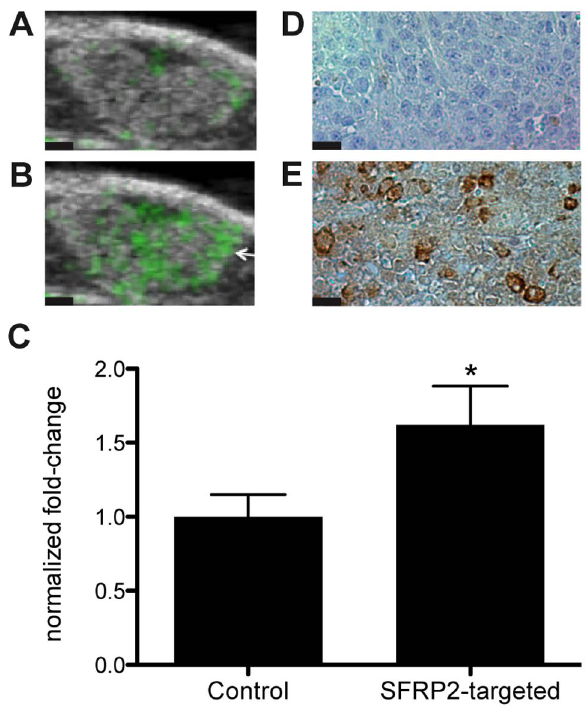
Figure 2. SFRP2 -targeted microbubbles bound specifically to vasculature within angiosarcoma. B-mode images of the SVR angiosarcoma tumors were overlaid in green with molecular images of (A) control streptavidin loaded microbubbles or (B) SFRP2 -targeted microbubbles after three-dimensional molecular imaging. The average pixel intensity observed for SFRP2 -targeted imaging was significantly higher (*p=0.003, n=13, paired t-test, two-tailed) than observed for the streptavidin control (C). Immunohistochemistry demonstrated high levels of expression for SFRP2 in angiosarcoma (D). Black scale bars in panels A and B represent 1 mm. Black scale bars in panels D and E represent 35 m m.